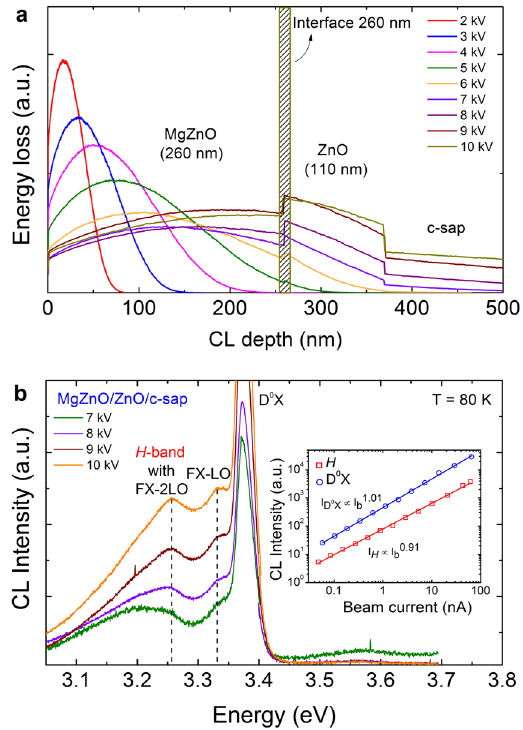
Figure 3. Depth-resolved CL measurements of the MgZnO/ZnO/c-sapphire bilayer. ( a ) CASINO simulated electron energy loss curves for acceleration voltages from 2 kV to 10 kV. The vertical axis corresponds to the percentage of CL generated at that particular depth. ( b ) Depth-resolved CL spectra of the bilayer structure acquired at different acceleration voltages with constant beam power I o V o = 28 µ W. The H -band emerges when the electron beam reaches the MgZnO/ZnO interface. Inset shows power density measurements of the MgZnO/ ZnO bilayer for D 0 X and H -band emissions at 80